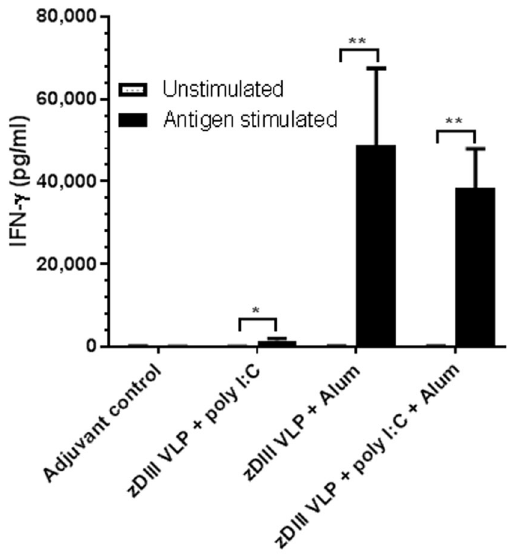
Figure 7. IFN- γ production by splenocytes from immunized mice. Spleen cells from mice inoculated with PBS + adjuvant or HBcAg-zDIII VLP with indicated adjuvant were stimulated with zDIII for 48 hr. The production of IFN- γ was quantitated by ELISA. Mean concentrations (pg/ml) and SD from three independent experiments with technical triplicates are presented. ** and * indicate p values = 0.0023 and 0.0286 of IFN- γ levels secreted by zDIII-stimulated splenocytes compared to that of unstimulated splenocytes.